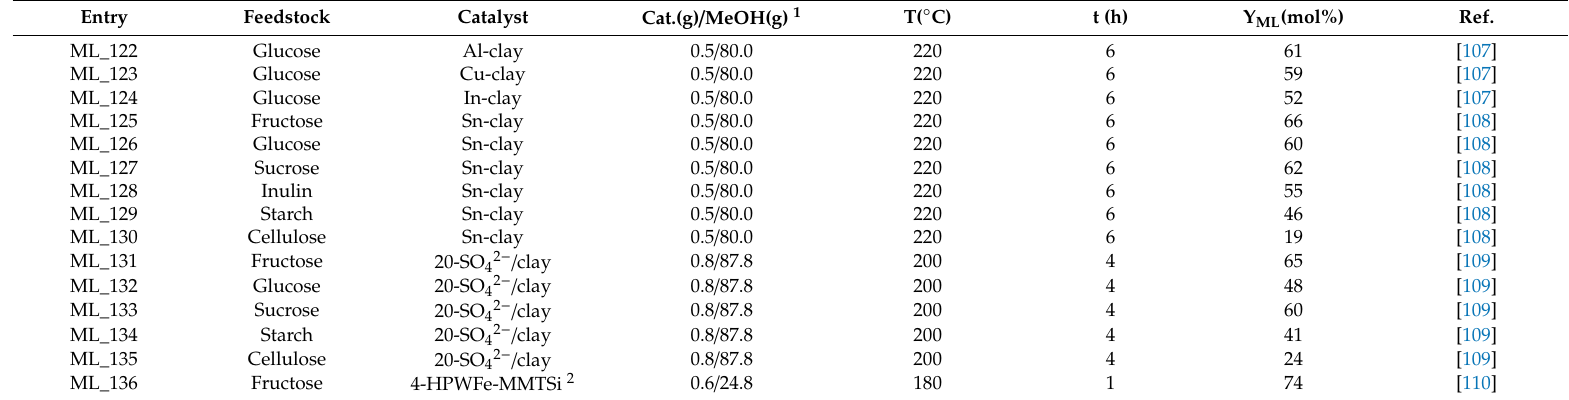
Table 5. Montmorillonite (clay)–based catalysts the ML production from C6 model carbohydrates, under conventional